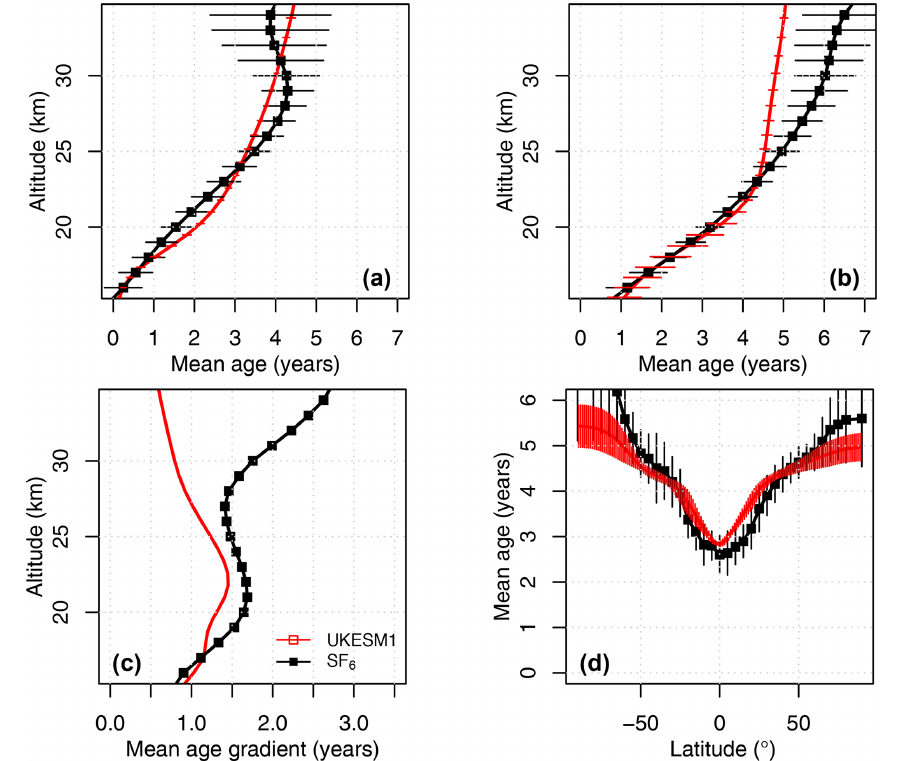
Figure 28. Comparison of multi-annual mean FR modelled (red) age of air with values derived from MIPAS observations of SF 6 (black) (Stiller et al., 2008). (a) Tropical profile. (b) NH mid-latitude profile. (c) Mid-latitude tropics profile. (d) Mean age at 23km ( ∼